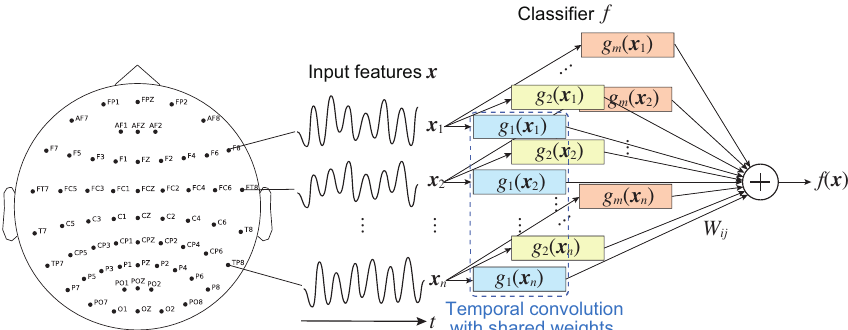
Figure 2. Model architecture for EEG signal classification using the CNN with constraints. Time-series signals measured by electrode x i for i = 1, . . . , n are fed into temporal convolution layers g j ( x i ) for j = 1, . . . , m . The input features are not spatially convolved owing to the independent constraint. The processing g j ( x i ) consists of the same parameterization owing to the identical constraint. If a classifier satisfies these constraints, the compensated IG can reliably compute the spatial contributions of x i to the